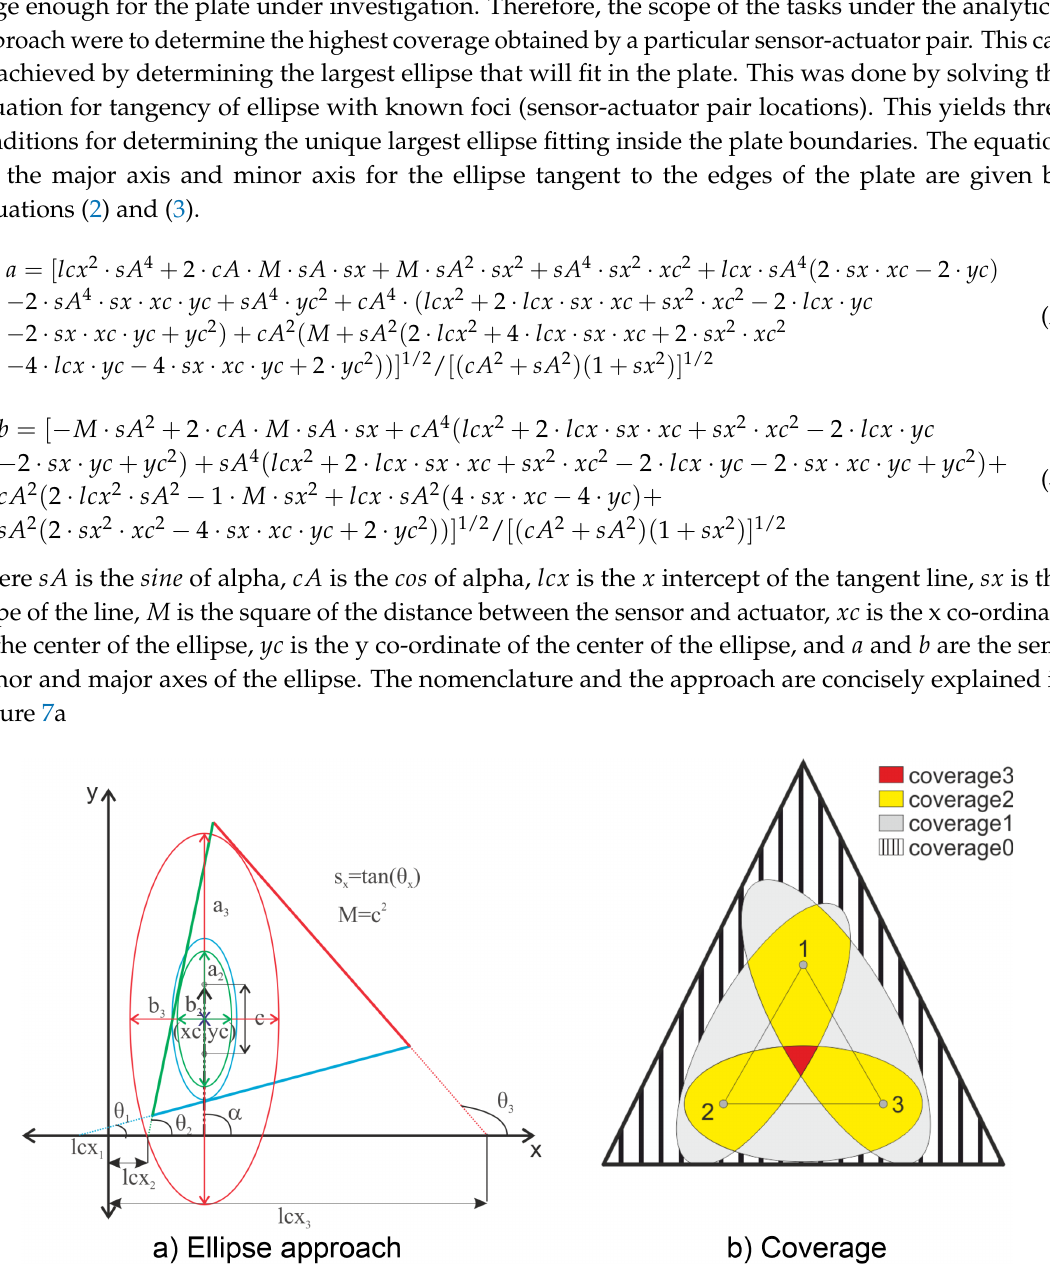
Figure 7. ( a ) Nomenclature for the ellipse approach for a triangular plate; ( b ) Explanation of coverage